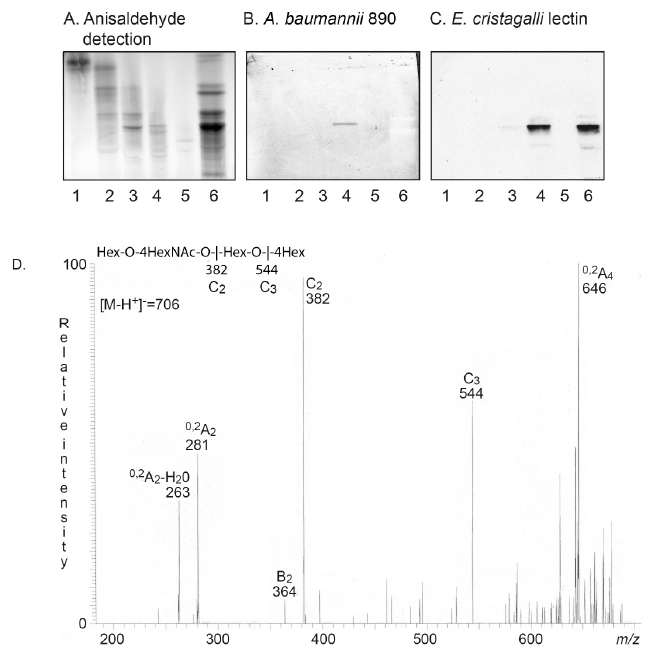
Figure 6. Non-acid glycosphingolipids of human skin: Characterization of neolactotetraosylceramide. ( A ) Chemical detection by anisaldehyde. ( B ) Autoradiogram obtained by binding of A. baumannii strain CCUG 890. ( C ) Autoradiogram obtained by binding of Gal β 4GlcNAc-recognizing lectin from Erythrina crista-galli. The lanes were: Lanes 1–5, fractions S-1–S-5 isolated from human skin, 4 µ g / lane; Lane 6, reference non-acid glycosphingolipids of human erythrocytes blood group AB, 40 µ g. ( D ) MS 2 spectrum of the ion at m/z 706 (retention time 21.0 min) from LC-ESI / MS of the oligosaccharides derived from fraction S-4 from human skin by digestion with Rhodococcus endoglycoceramidase II. The interpretation formula shows the deduced oligosaccharide sequence.